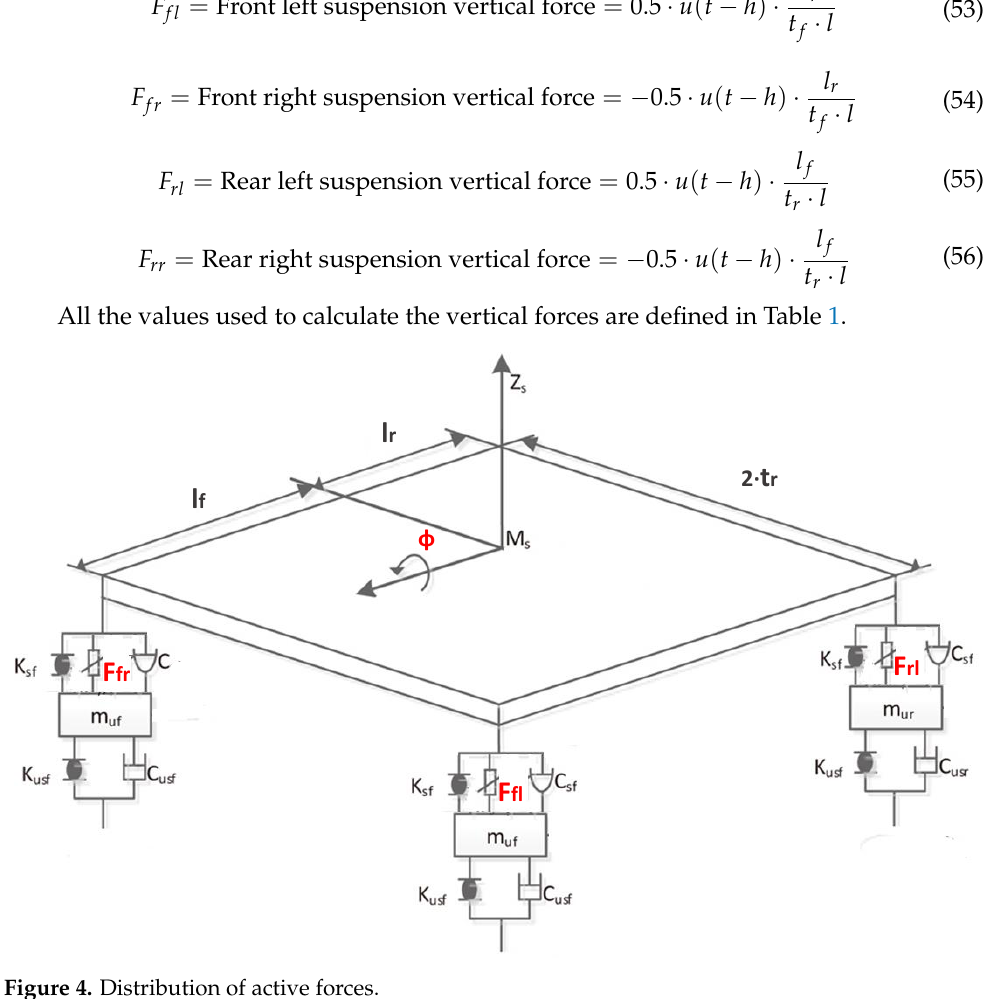
Figure 4. Distribution of active